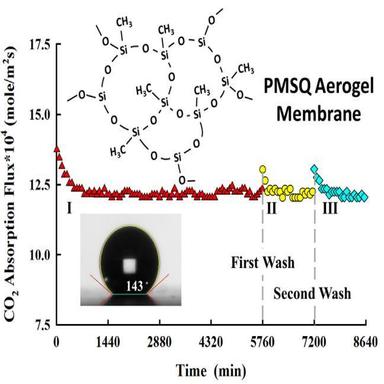
Scheme for CO2 gas absorption in a hydrophobic membrane contactor using hydrophobic mesoporous PMSQ aerogel membranes. Reprinted with permission from Ref..